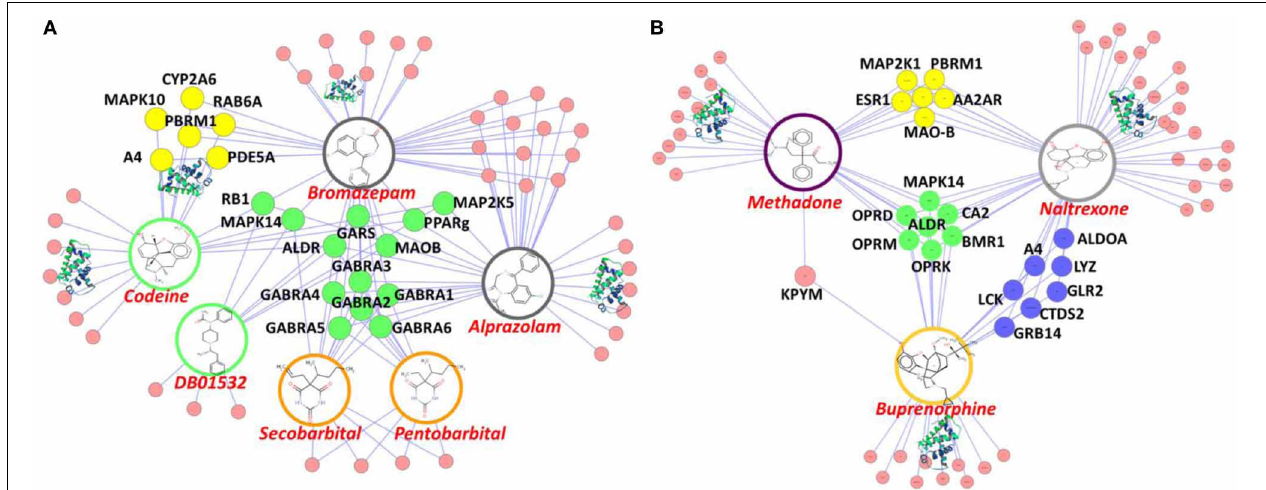
FIGURE 3 | Illustration of our cloud-based HTDocking server to predict potential targets (pink nodes) and cross-targets (yellow, green and blue nodes) of compounds and to explore possible mechanisms. (A) The predicted targets of six known abused/approved drugs ( opioids : codeine and DB01532; benzodiazepines : bromazepam and alprazolam; barbiturates : secobarbital and pentobarbital). (B) The predicted targets of 3 approved drugs for DA treatments (methadone, naltrexone, and buprenorphine). MAPK10, Mitogen-Activated Protein Kinase 10; CYP2A6, cytochrome P450, family 2, subfamily A, polypeptide 6; RAB6A, RAB6A , member RAS oncogene family; PBRM1, polybromo 1; PDE5A, phosphodiesterase 5A, cGMP-specific; A4, amyloid beta protein; RB1, retinoblastoma 1; MAPK14,